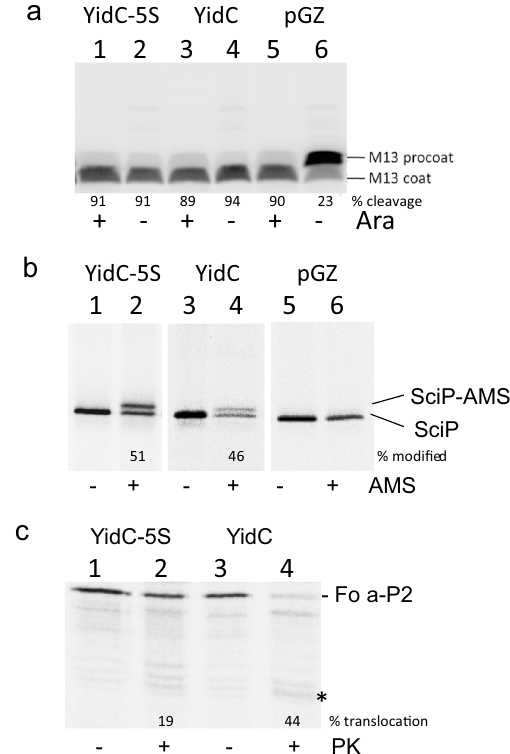
Figure 2. YidC-5S is fully functional for the membrane insertion of only Sec-independent substrates. The plasmid encoded YidC-5S mutant was tested for its function as a membrane insertase in E. coli MK6 under YidC-depleted conditions. A second plasmid encoding the substrate protein was co-transformed. The cells bearing the respective plasmids were grown in the presence of glucose to deplete the chromosomal YidC. As control, a culture bearing the vector (pGZ) was analysed in parallel (lanes 5, 6). ( a ) The expression of M13 procoat was induced with IPTG for 10 min and 35 S-methionine was added for 1 min and the cells were analysed for cleavage of the M13 procoat protein to the mature coat in cells co-expressing YidC-5S (lane 2), YidC (lane 4) or with an empty plasmid (lane 6). For a control, the cleavage was followed under non-depleted conditions (+Ara, odd lanes). ( b ) SciP with a cysteine residue at 218 in the C-tail was co-expressed with YidC-5S (lanes 1, 2), YidC (lanes 3, 4) or where the empty plasmid was present (lanes 5, 6) and pulse-labelled for 2 min. The cells were non-treated (lanes 1, 3, 5) or treated with AMS to modify the cysteine and shift the protein by 0.5 kDa when the C-terminal tail was translocated to the periplasm (lane 2, 4, 6). ( c ) Membrane insertion of ATP synthase subunit a that was extended with the P2 domain of leader peptidase at the C-terminus was monitored in the YidC-depleted JS7131 cells. The cells expressing YidC-5S (lanes 1, 2) or YidC (lanes 3, 4) with subunit a-P2 were pulse-labelled with 35 S-methionine for 1 min, converted to spheroplasts and analysed by protease mapping. Proteinase K was added (lanes 2, 4) or not (lanes 1, 3). When the protein was digested with Proteinase K, a protease-resistant fragment was generated (see asterisk). For a control, the cellular protection of cytosolic proOmpA and the digestion of OmpA by the protease were documented (Fig. S2). In all cases, the total cell protein was immunoprecipitated and analyzed by SDS-PAGE and phosphorimaging. The percentage of the cleavage of M13 procoat, of the modification of SciP with AMS and the protease accessibility of Fo-a-P2 were quantified and the values are